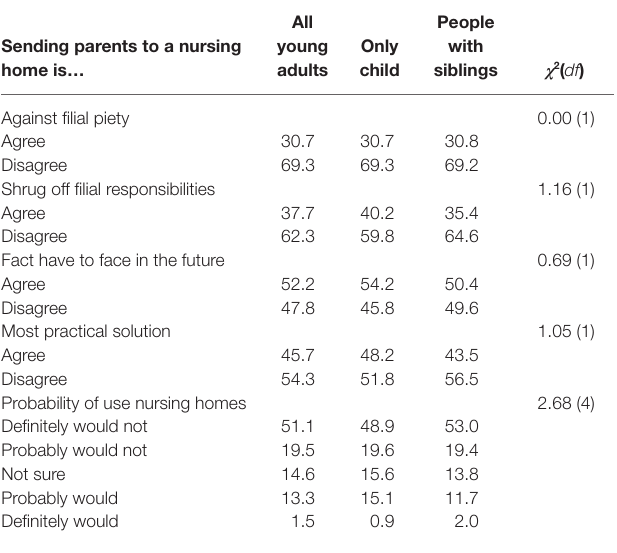
All People young Only with adults child siblings